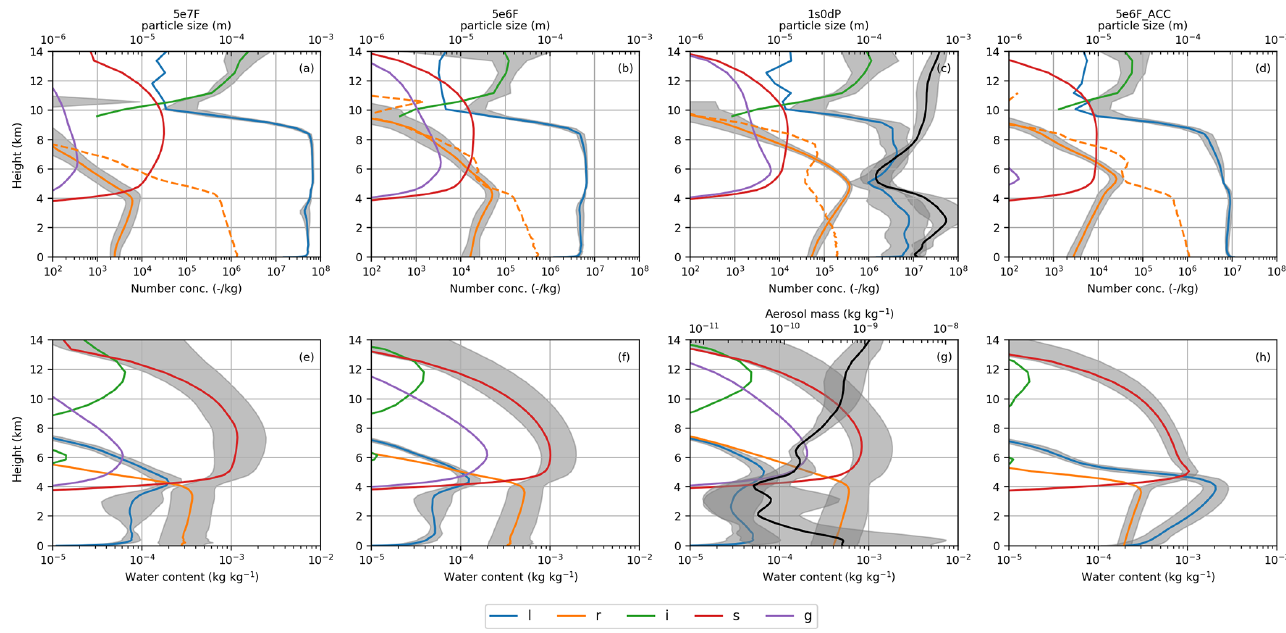
Figure 4. Vertical profiles of hydrometeor number concentrations (a–d) and mass concentrations (e–h) time-averaged within a 2 × 2 ◦ box moving with the centroid of surface rain rate: (a, e) 5e7F, (b, f) 5e6F, (c, g) 1s0dP and (d, h) 5e6F_ACC. The colours correspond to the hydrometeor species according to the key shown on the left. The black lines in panels (c, g) show the profiles of the aerosol number and mass concentration in the aerosol-processing experiment (1s0dP). The grey regions show the variabilities (defined as ± 1 geometric standard deviation) in the number and mass concentrations of cloud droplets, raindrops and the totality hydrometeor, according to whichever parameter has the largest variability at each point. In panel (c) , the standard deviation around the aerosol number concentration profile is also shown.